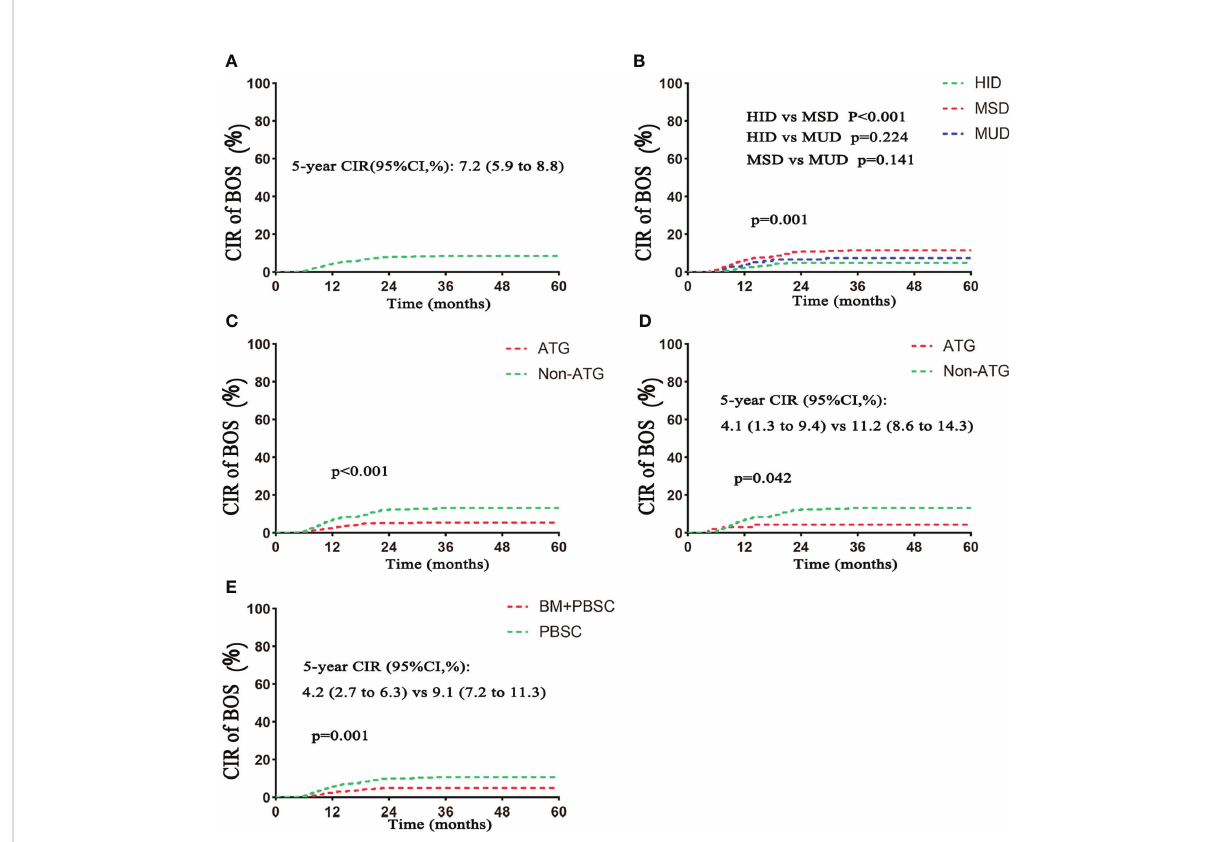
FIGURE 1 Cumulative incidence of BOS. (A) CIR of BOS in the total population. (B) CIR of BOS based on donor type. (C) CIR of BOS based on ATG. (D) CIR of BOS based on ATG in the MSD subgroup. (E) CIR of BOS based on grafts. CIR, cumulative incidence rate. Follow – up started from transplantation. HID, haploidentical donor; MSD, HLA-matched siblingdonor; MUD, matched unrelated donor; PBSC, peripheral blood stem cell; BM, bone